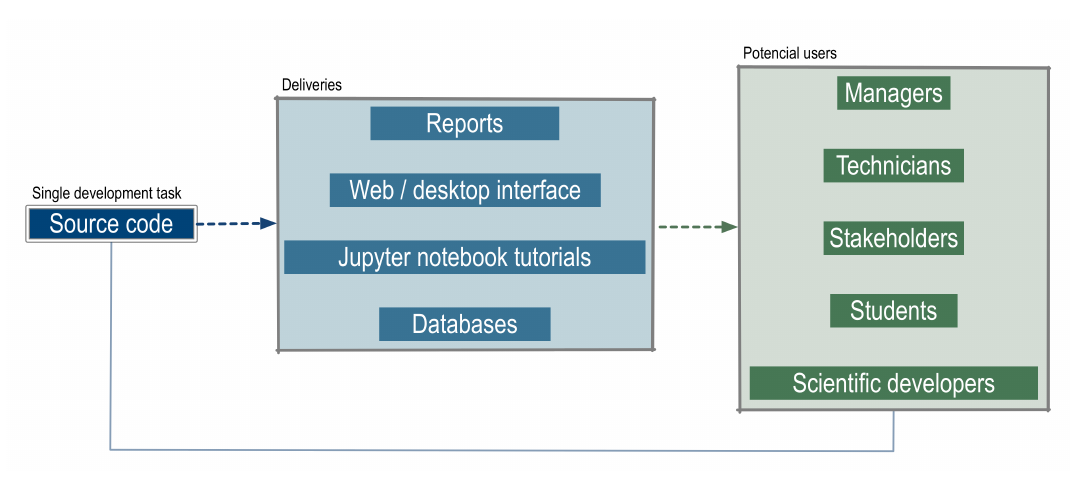
Figure 3. Diagram of the climate